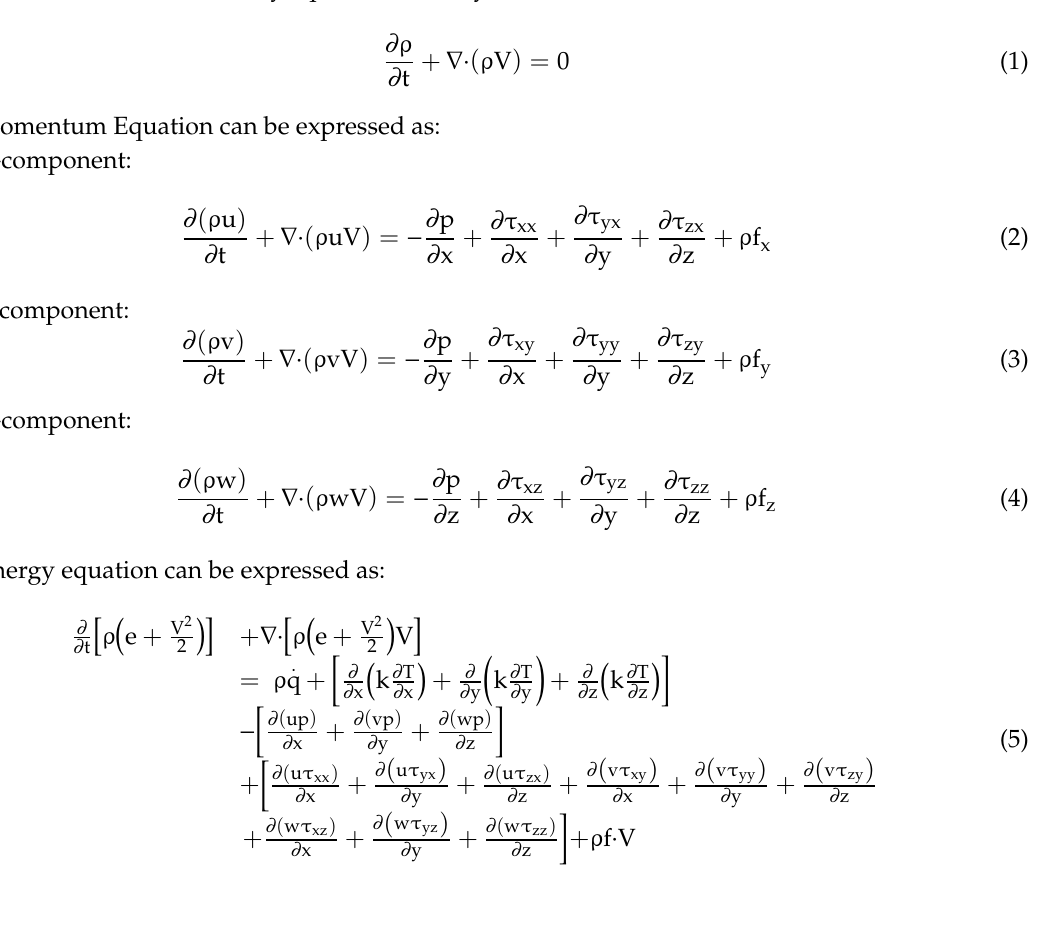
Figure 2. Three-dimensional circular domain.